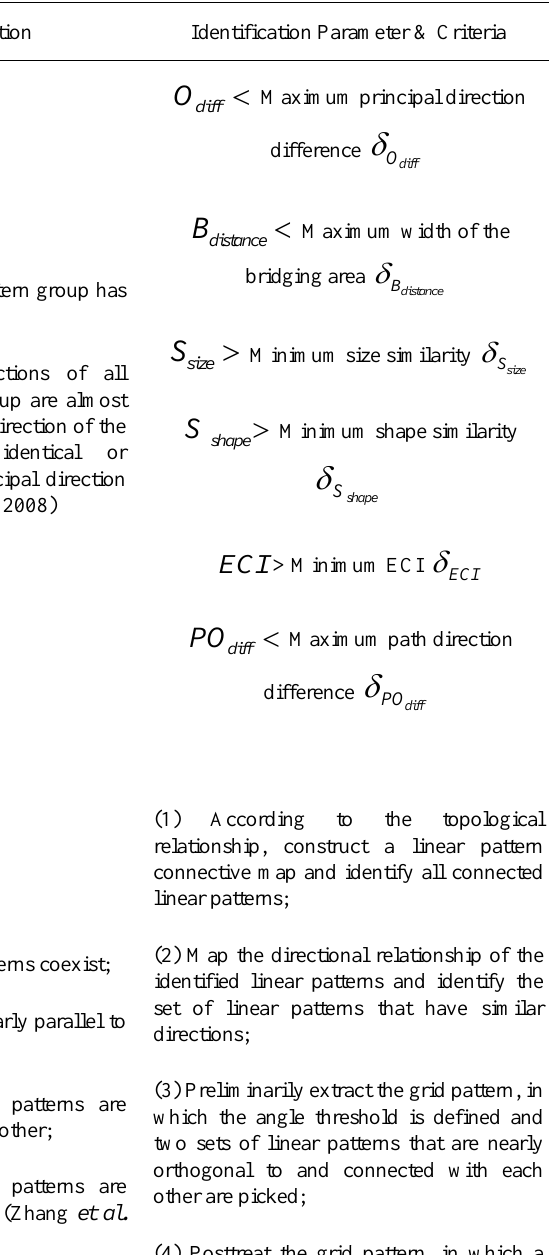
Table 1. Controlling parameters for the identification of structural characteristics of structured geographic